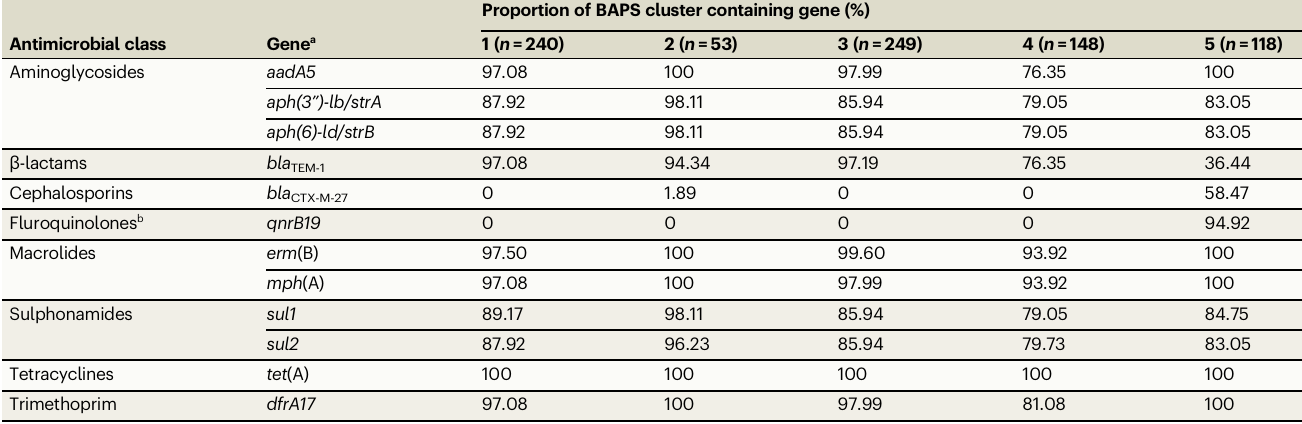
Table 1 | Proportion of isolates from the UK, Belgium and NSW carrying different AMR genes by BAPS cluster Proportion of BAPS cluster containing gene (%) Antimicrobial